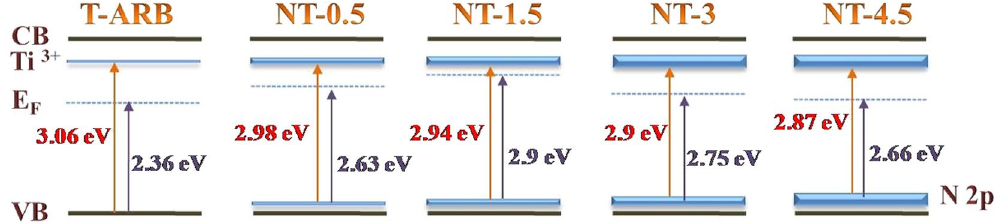
Figure 11. Effect of nitrogen doping in triphase TiO 2 nanotubes.